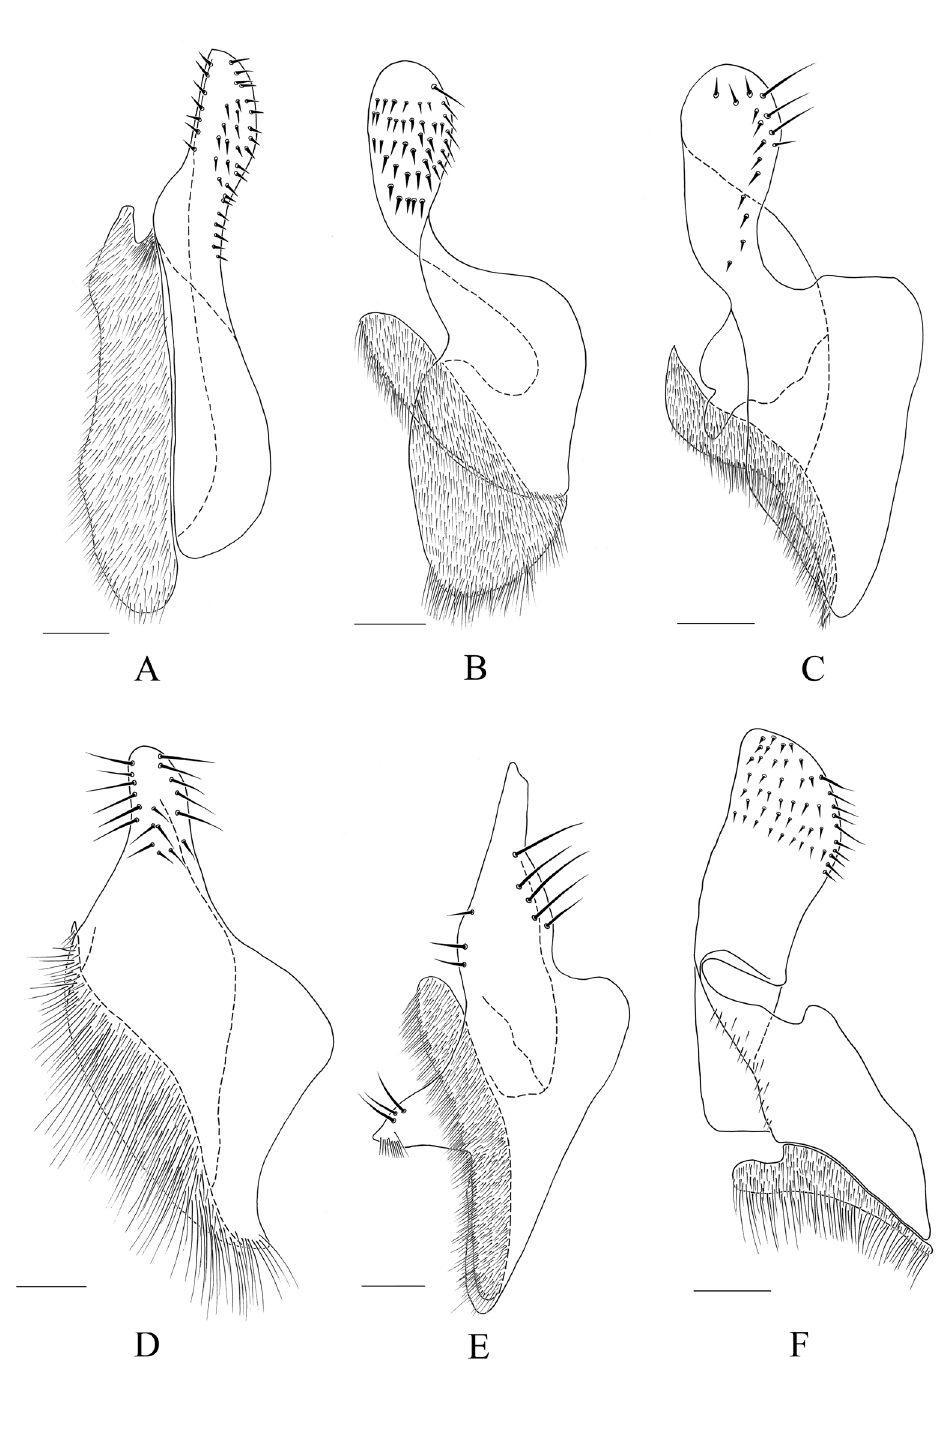
Fig. 20. Right surstylus, dorsal view. A . Eumerus atricolorus Gilasian & van Steenis sp. nov., holotype (HMIM). B . E. brevipilosus Gilasian & van Steenis sp. nov., holotype (HMIM). C . E. chekabicus Gilasian & van Steenis. sp. nov., holotype (HMIM). D . E. coeruleus (Becker, 1913), Chekab Valley, Iran (HMIM). E . E. ovoformus Gilasian & van Steenis sp. nov., holotype (HMIM). F . E. richteri Stackelberg, 1960, Lar, Iran (HMIM). Scale bars = 0.1